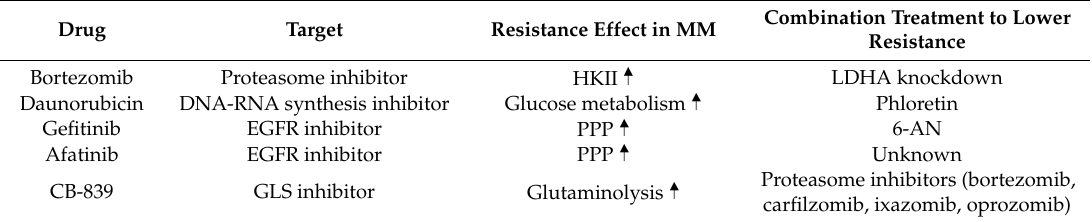
Table 1. Targets to decrease drug resistance in MM cells. 6-AN, 6-Aminonicotinamide; EGFR, epidermal growth factor; GLS, glutaminase; HKII; hexokinase II; LDHA, lactate dehydrogenase A; PPP, pentose phosphate